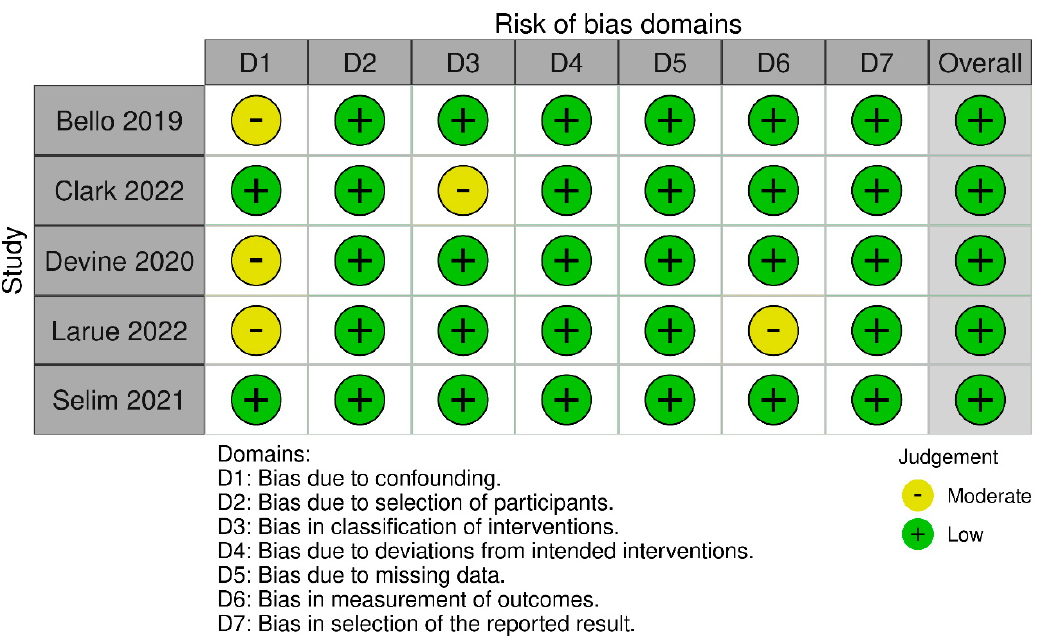
Figure 4. Forest plot of mean difference of length of stay comparing opioid − free anesthesia and opioid − based anesthesia [18,19,20].